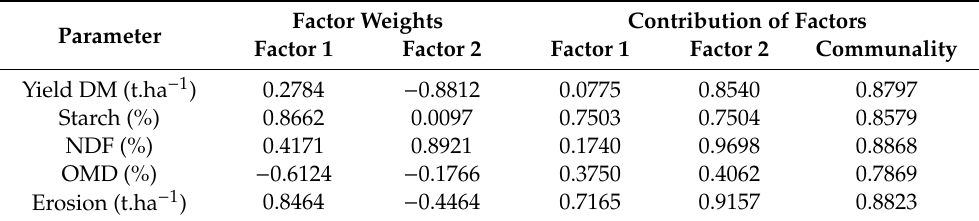
Table 1. Factor weights and contributions of a given factor to the communality for individual characters after normalized Varimax rotation for production (yield), forage quality (Starch, NDF and OMD) and soil erosion. Factor Weights Contribution of Factors Parameter Factor 1 Factor 2 Factor 1 Factor 2 Communality Yield DM (t.ha − 1 ) 0.2784 − 0.8812 0.0775 0.8540 0.8797 Starch (%) 0.8662 0.0097